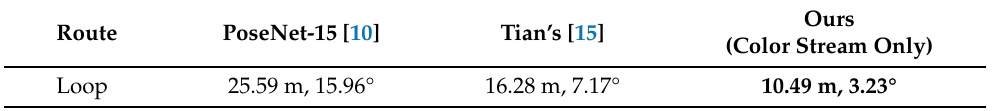
Table 4. Median translation error (m) and rotation error (°) for various APR methods on Oxford RobotCar . Bold numbers indicate the lowest error